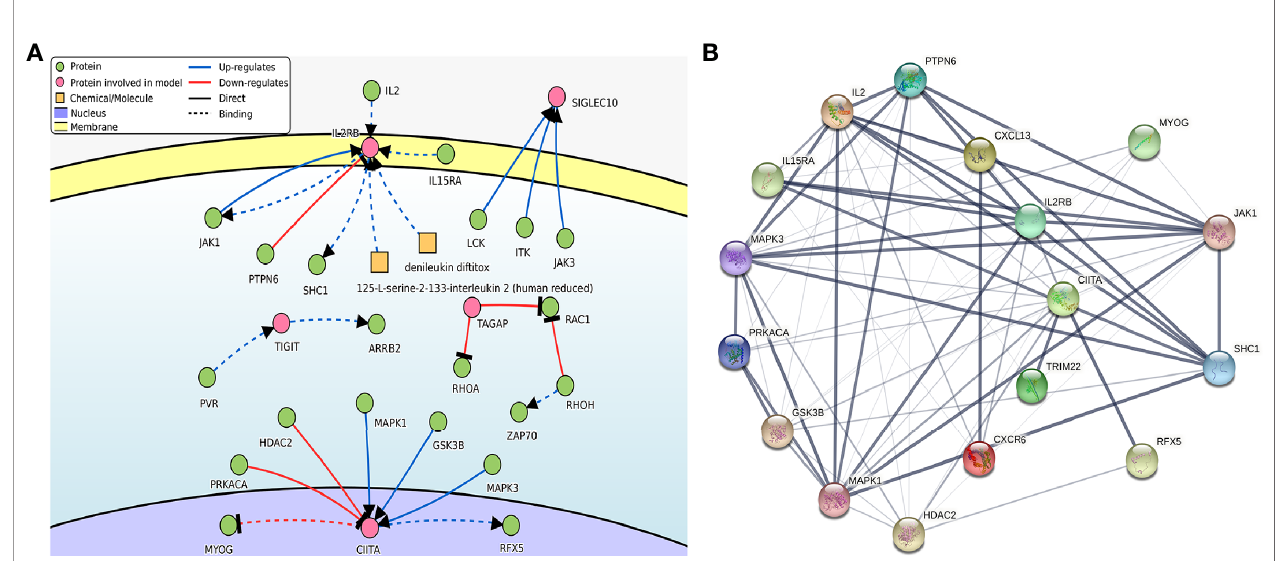
FIGURE 8 | (A) The causal interaction of key gene analysis in DisNor. (B) The PPI analyses between key genes and directly interacted genes. The thickness of the solid line represents the strength of the relationship. PPI, protein-protein